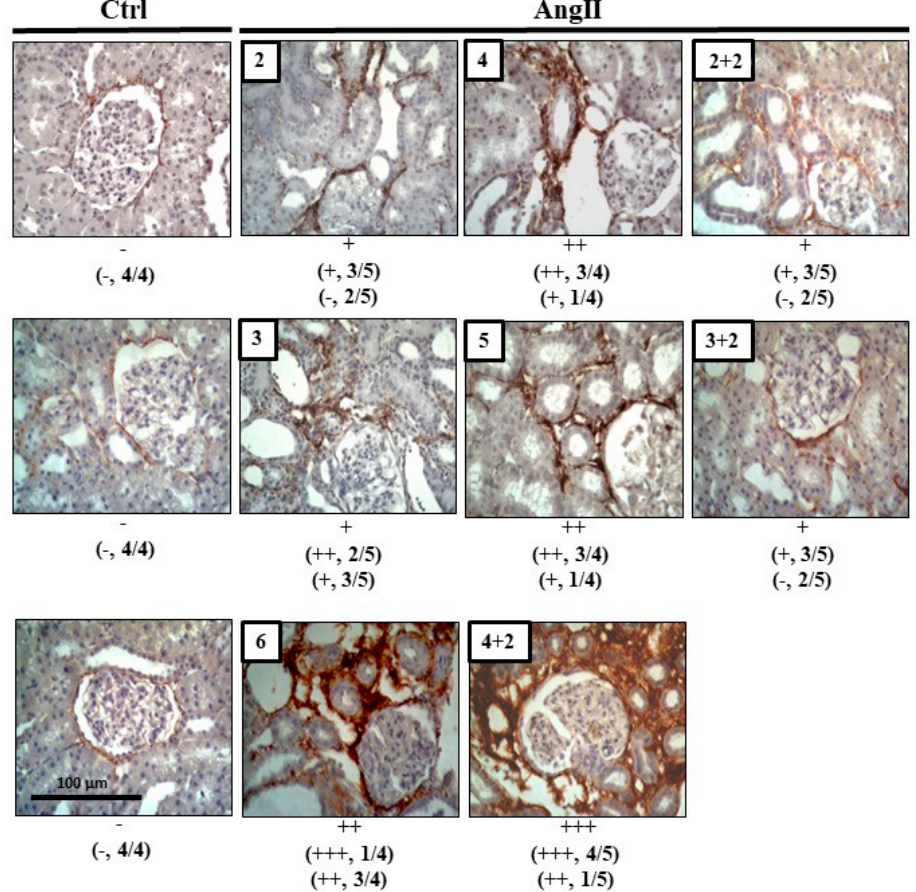
Figure 5. Col III remains high after 4 weeks of infusion with AngII. Immunostaining for Col III was performed in renal samples. Representative pictures of at least three di ff erent kidneys and four di ff erent fields are shown. Scale bar = 100 µ m. Brown staining represents the marker for Col III. The semi-quantitative morphometric analysis for Col III was performed as explained in Materials and Methods.